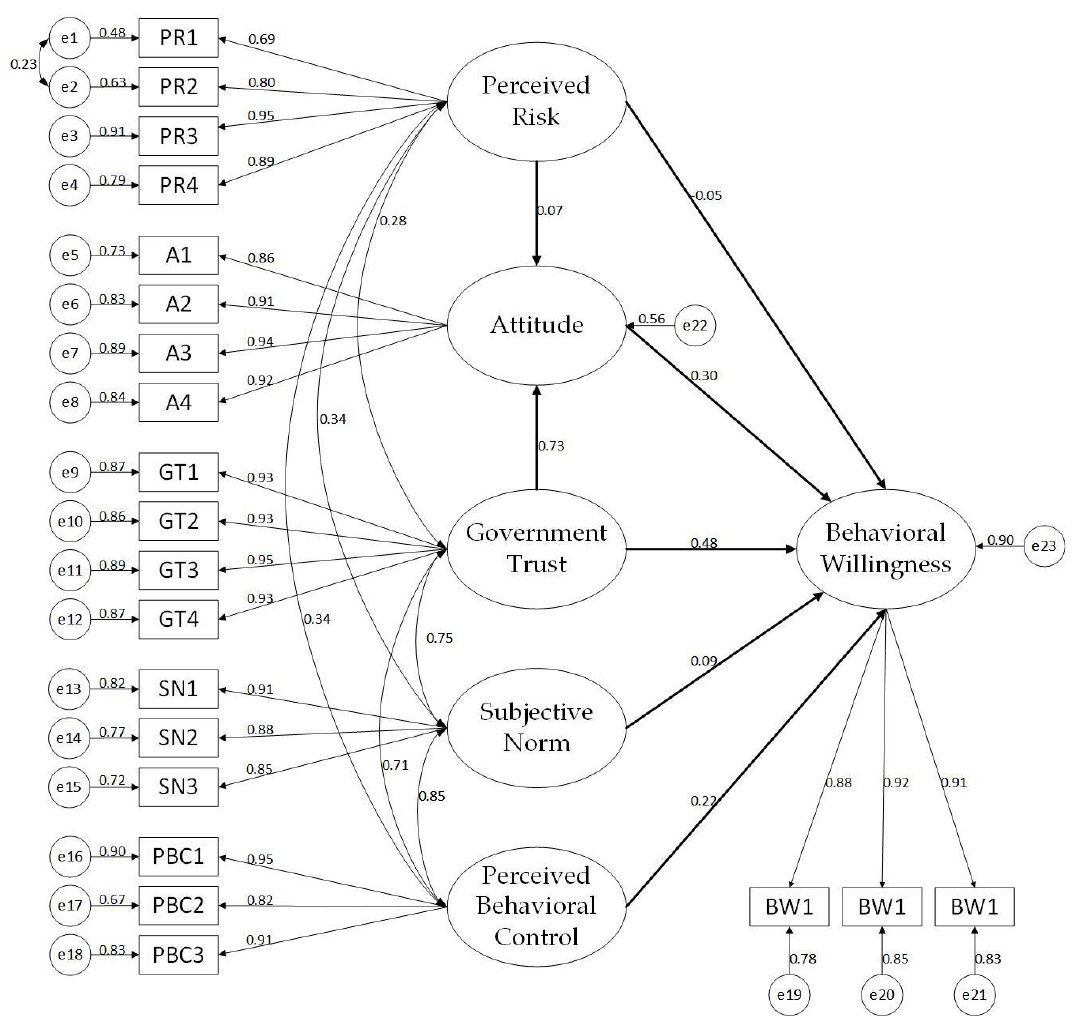
Figure 3. Model 2 of residents’ behavioral willingness.